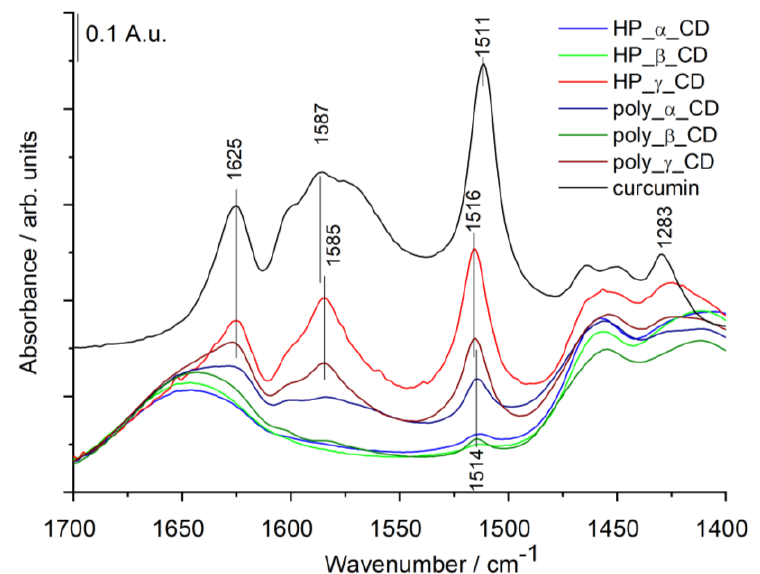
Figure 6. Typical IR absorption bands of curcumin (pure curcumin from ethanol solution and curcumin loaded CD samples).